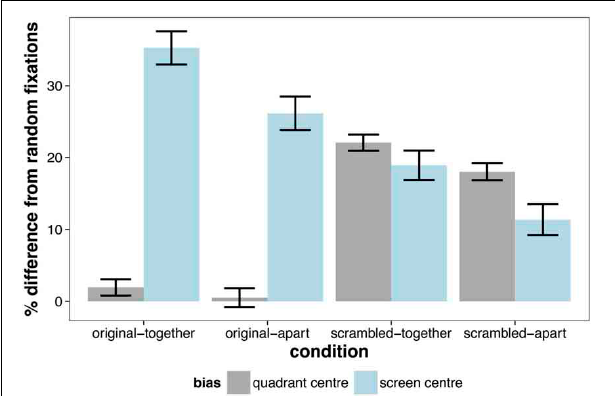
FIGURE 8 | Percentage improvement from random fixations for biases of the scene (quadrant) center and of the screen center in the top left quadrant. Error bars indicate ±